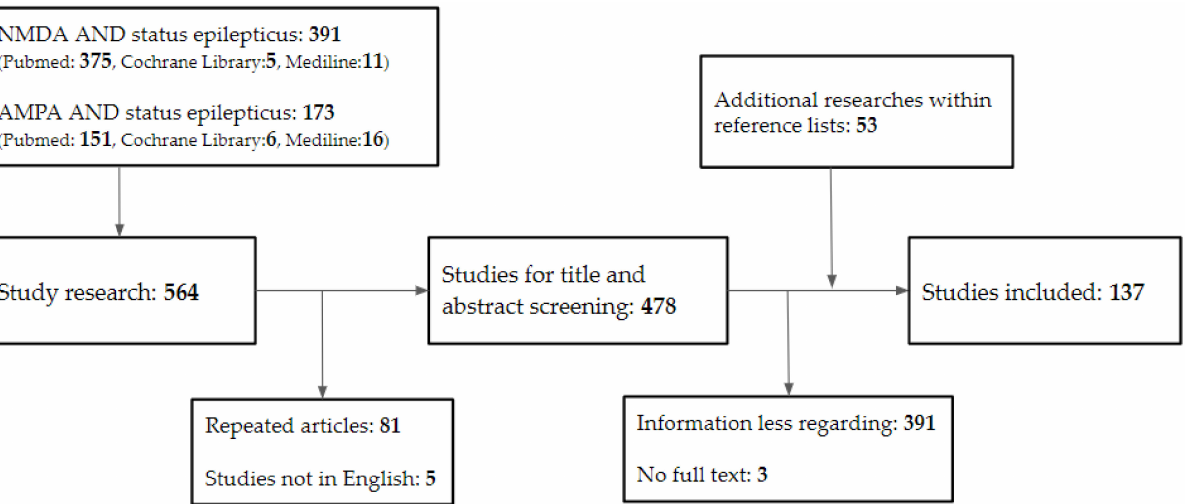
Figure 1. Database search flowchart. NMDA, N-methyl-D-aspartate; AMPA, α -amino-3-hydroxy-5- methyl-4-isoxazolepropionic